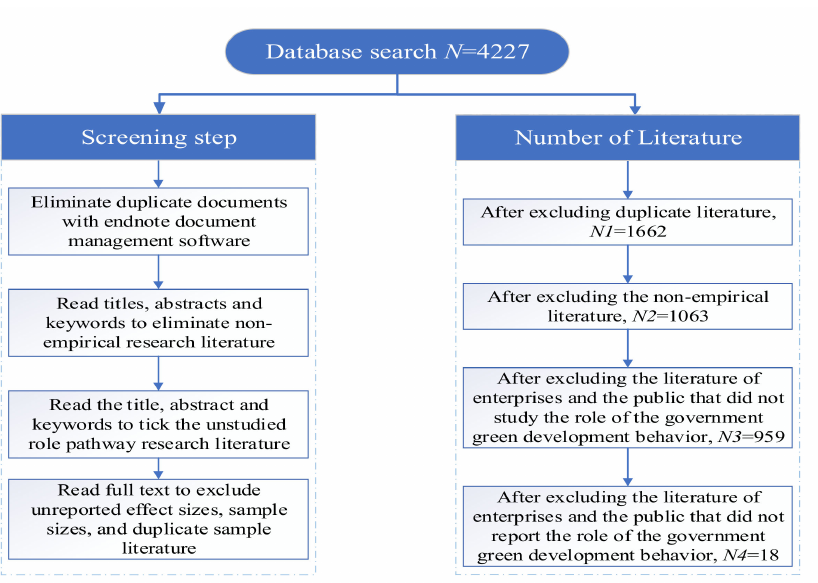
Figure 4. Sample literature screening